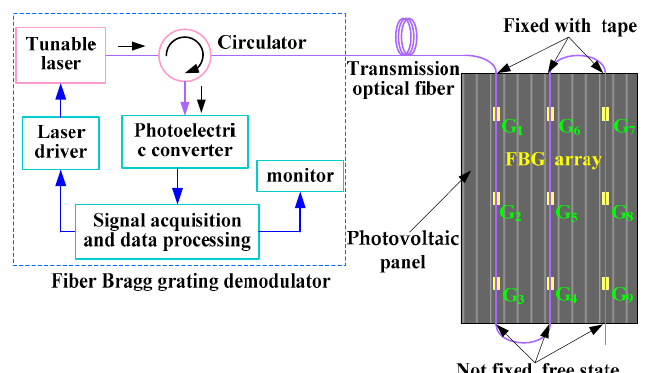
Figure 4. Structure diagram of distributed FBG sensor system.